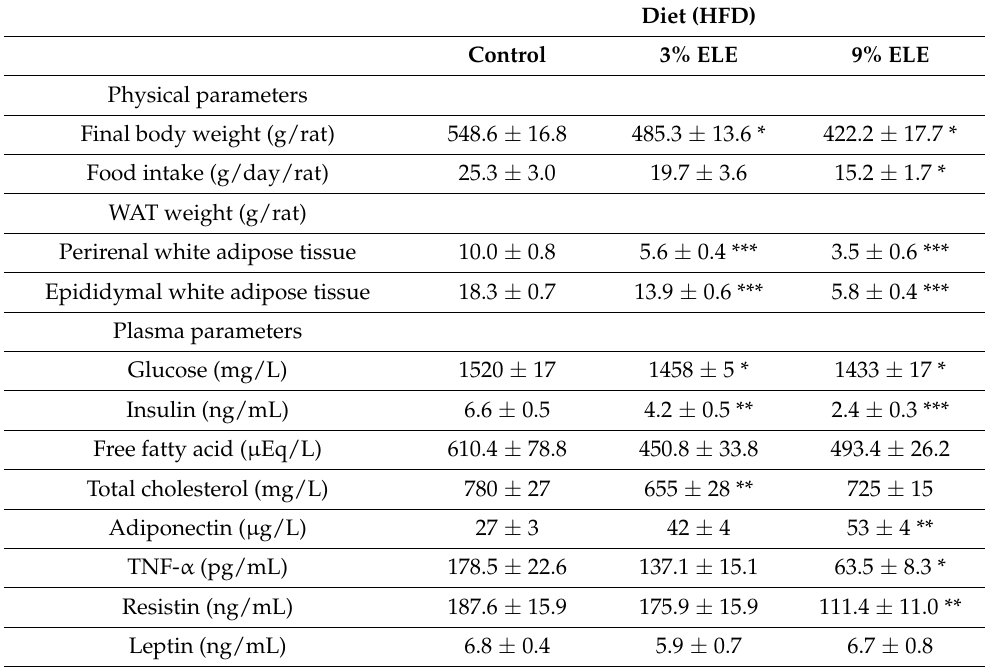
Table 3. Effects of ELE on physical and plasma parameters after a three-month administration in HFD-fed rats.